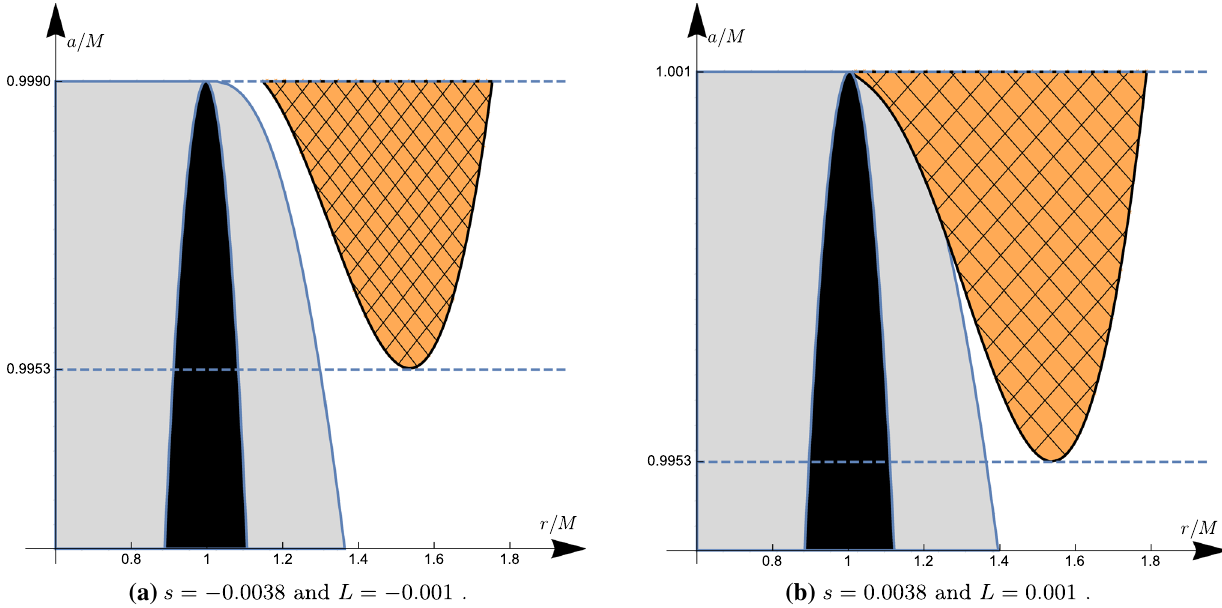
Fig. 4 The a − r parameter space with hatched region, where the Aschenbach effect can be observed in general case. The region outside the event > 0. The value of the critical spin of the black hole is the same as in the case of non-spinning particle with zero (cid:2) horizon corresponds to V + dr spin values are not constrained remaining an open